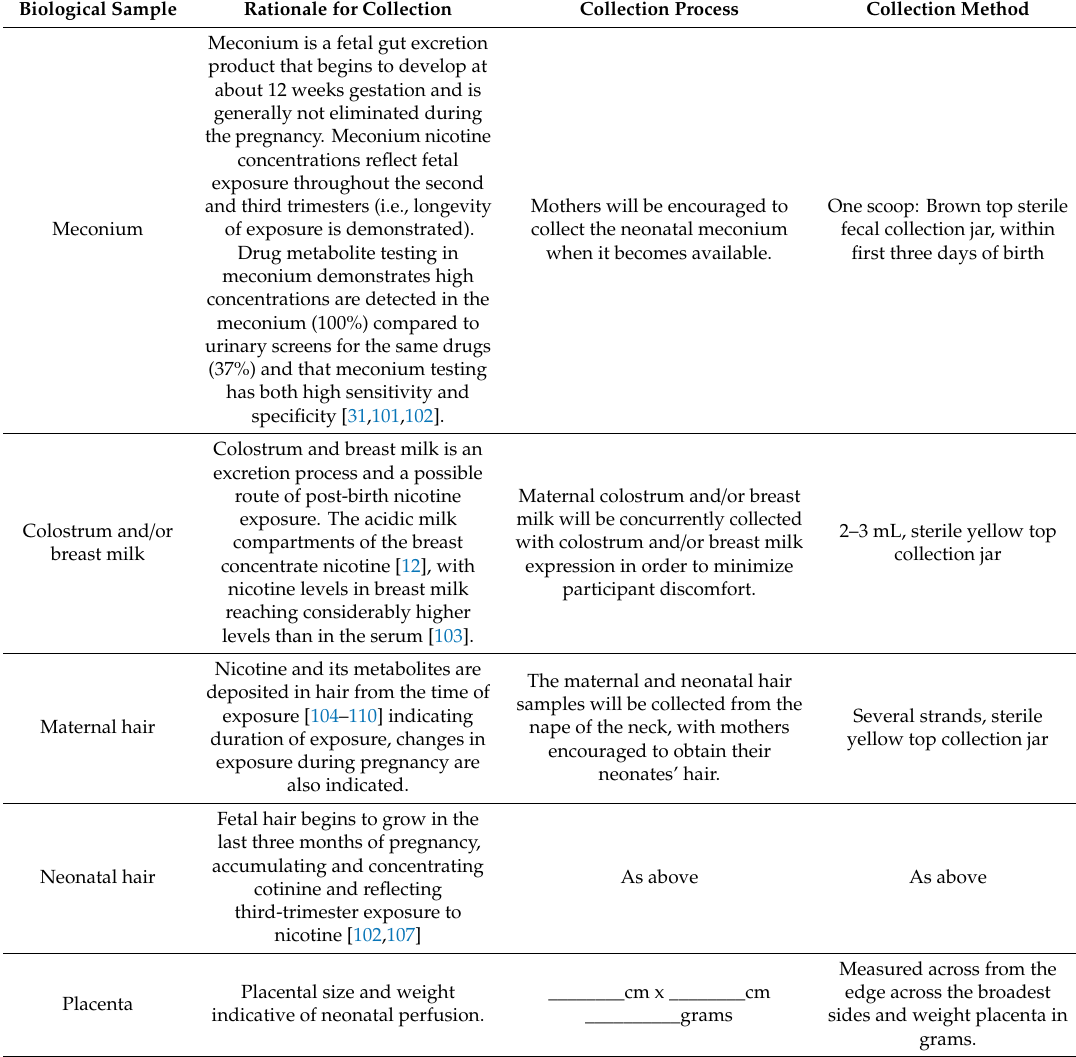
Table 4. Biological sample, rationale for collection and collection